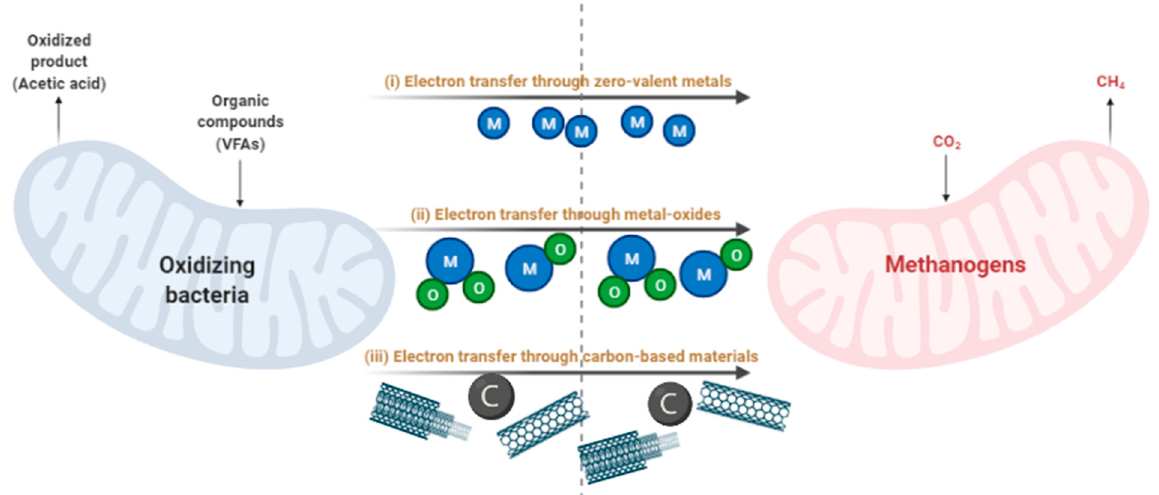
Figure 4. Application of conductive nanoparticles for electron transfer between oxidizing bacteria and methanogens via (i) zero ‐ valent metals; (ii) metal oxides, and (iii) carbon ‐ based materials.